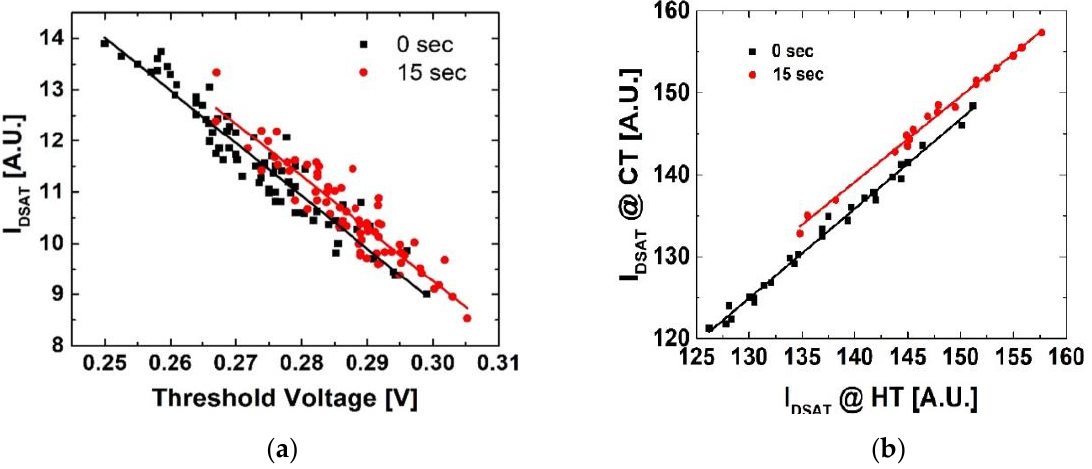
Figure 5. Single PMOSFET characteristics. ( a ) I DSAT as a function of processing time and threshold voltages. ( b ) I DSAT relationship between hot (85 ℃ ) and cold ( − 25 ℃ ) temperature. voltages. ( b ) I DSAT relationship between hot (85 °C) and cold (